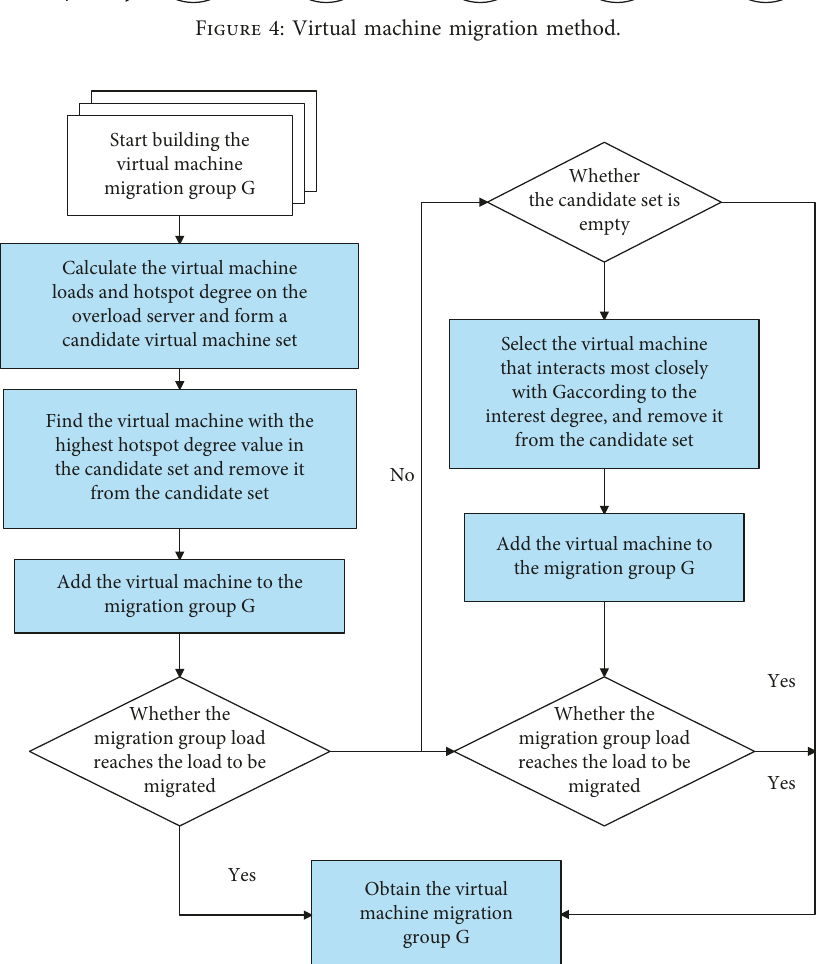
Figure 5: The process of building a virtual machine migration